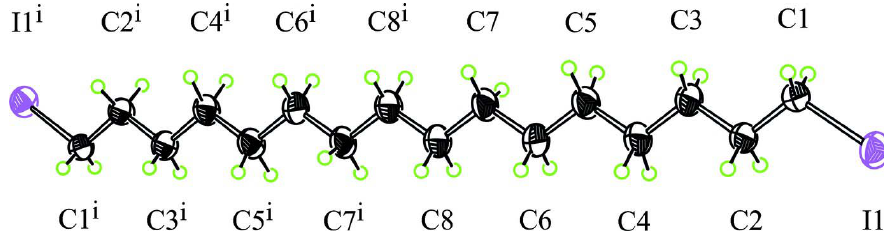
Figure 1 The molecular structure of (I), showing the atom numbering scheme. Displacement ellipsoids are drawn at the 50% probability level [symmetry code: (i) 1 - x , 1 - y , 2 - z